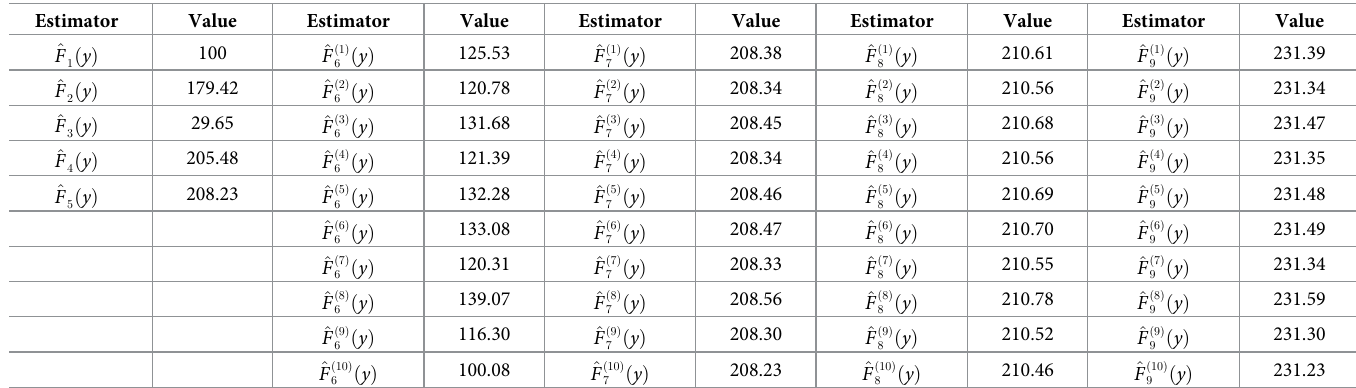
Table 16. PREs of distribution function estimators using Population IV.